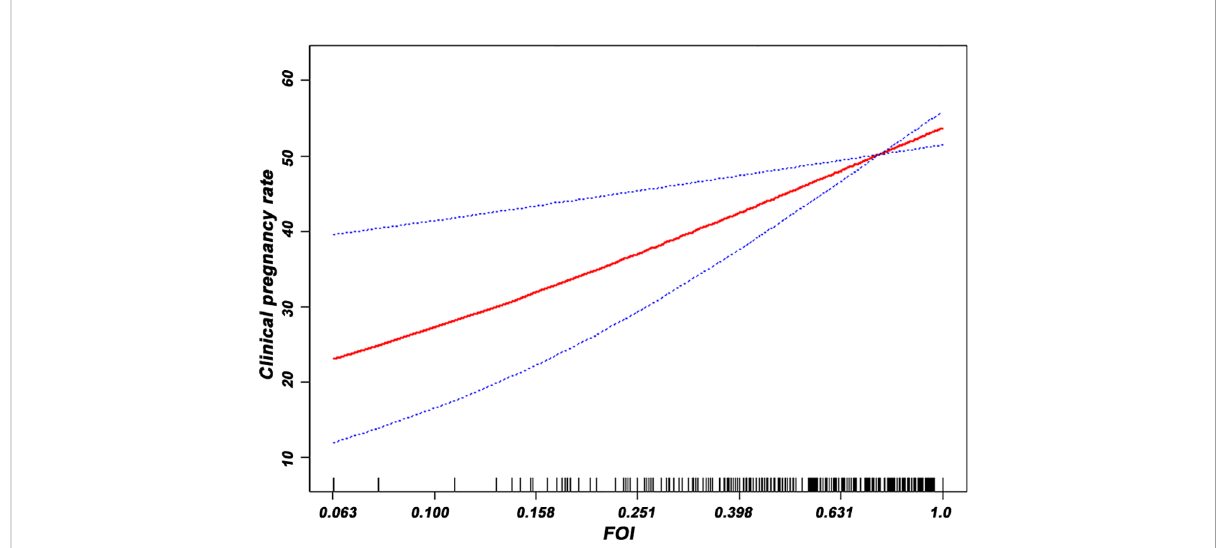
FIGURE 2 Smooth curve fi tting was performed using GAM to assess the linearity of the association between the FOI and the